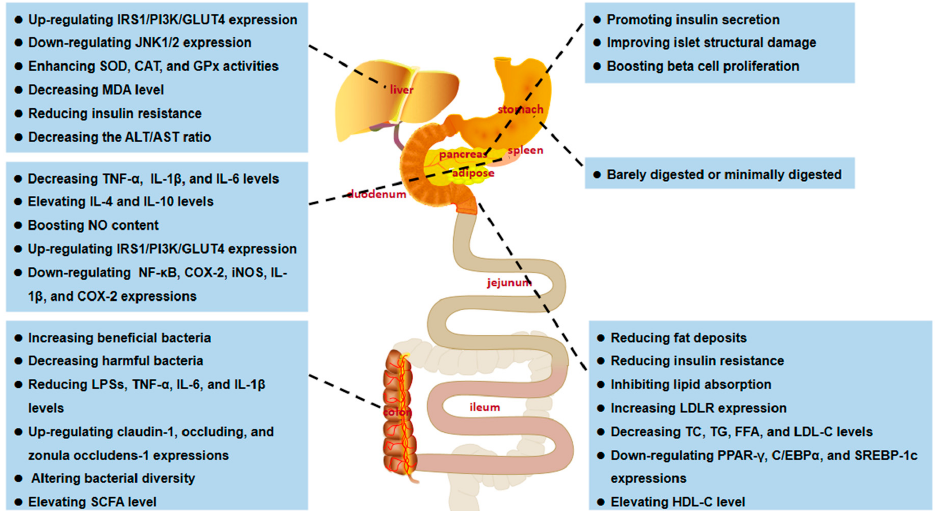
Figure 12. A potential mechanism by which edible fungal polysaccharides exert their in vivo